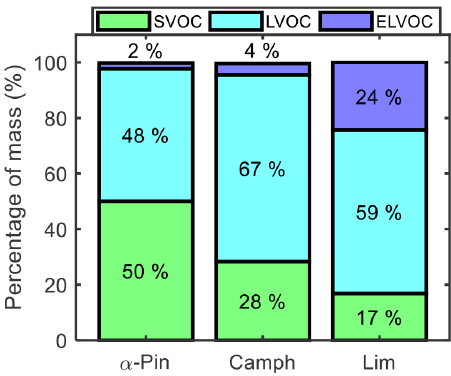
Figure 11. Mass percentage of four volatility categories in the par- ticle phase at the end of the controlled reactivity simulations for α -pinene, camphene, and